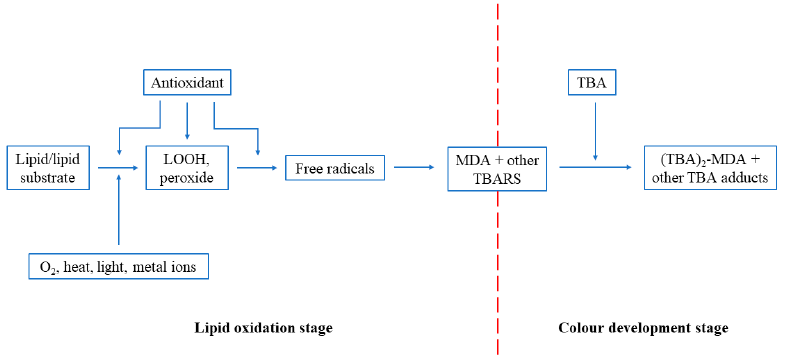
Figure 6. Steps involved in the lipid oxidation and antioxidant action in the TBARS activity assay.